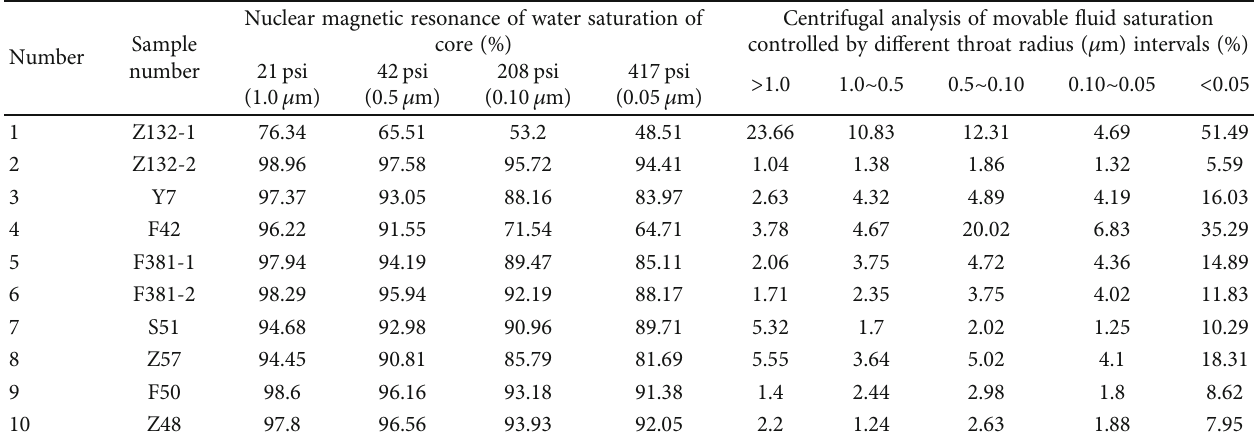
Table 2: Nuclear magnetic resonance results of tight sandstone in the 4th formation of